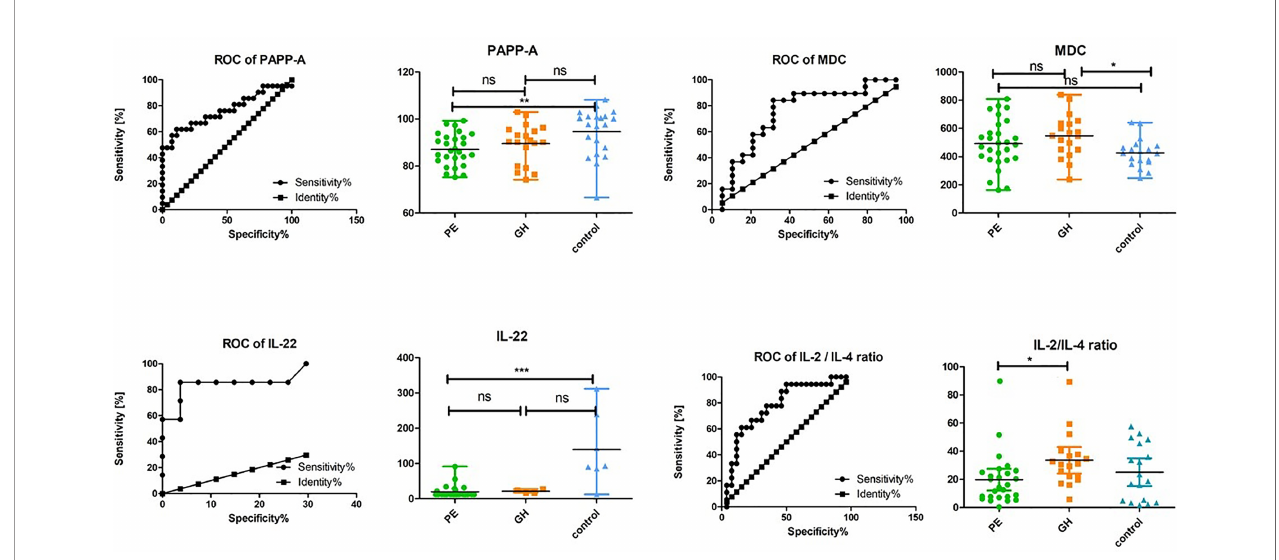
FIGURE 3 | AUC of selected parameters. *p < 0,050; **p < 0,025; ***p < 0,001; ns, non-signi fi